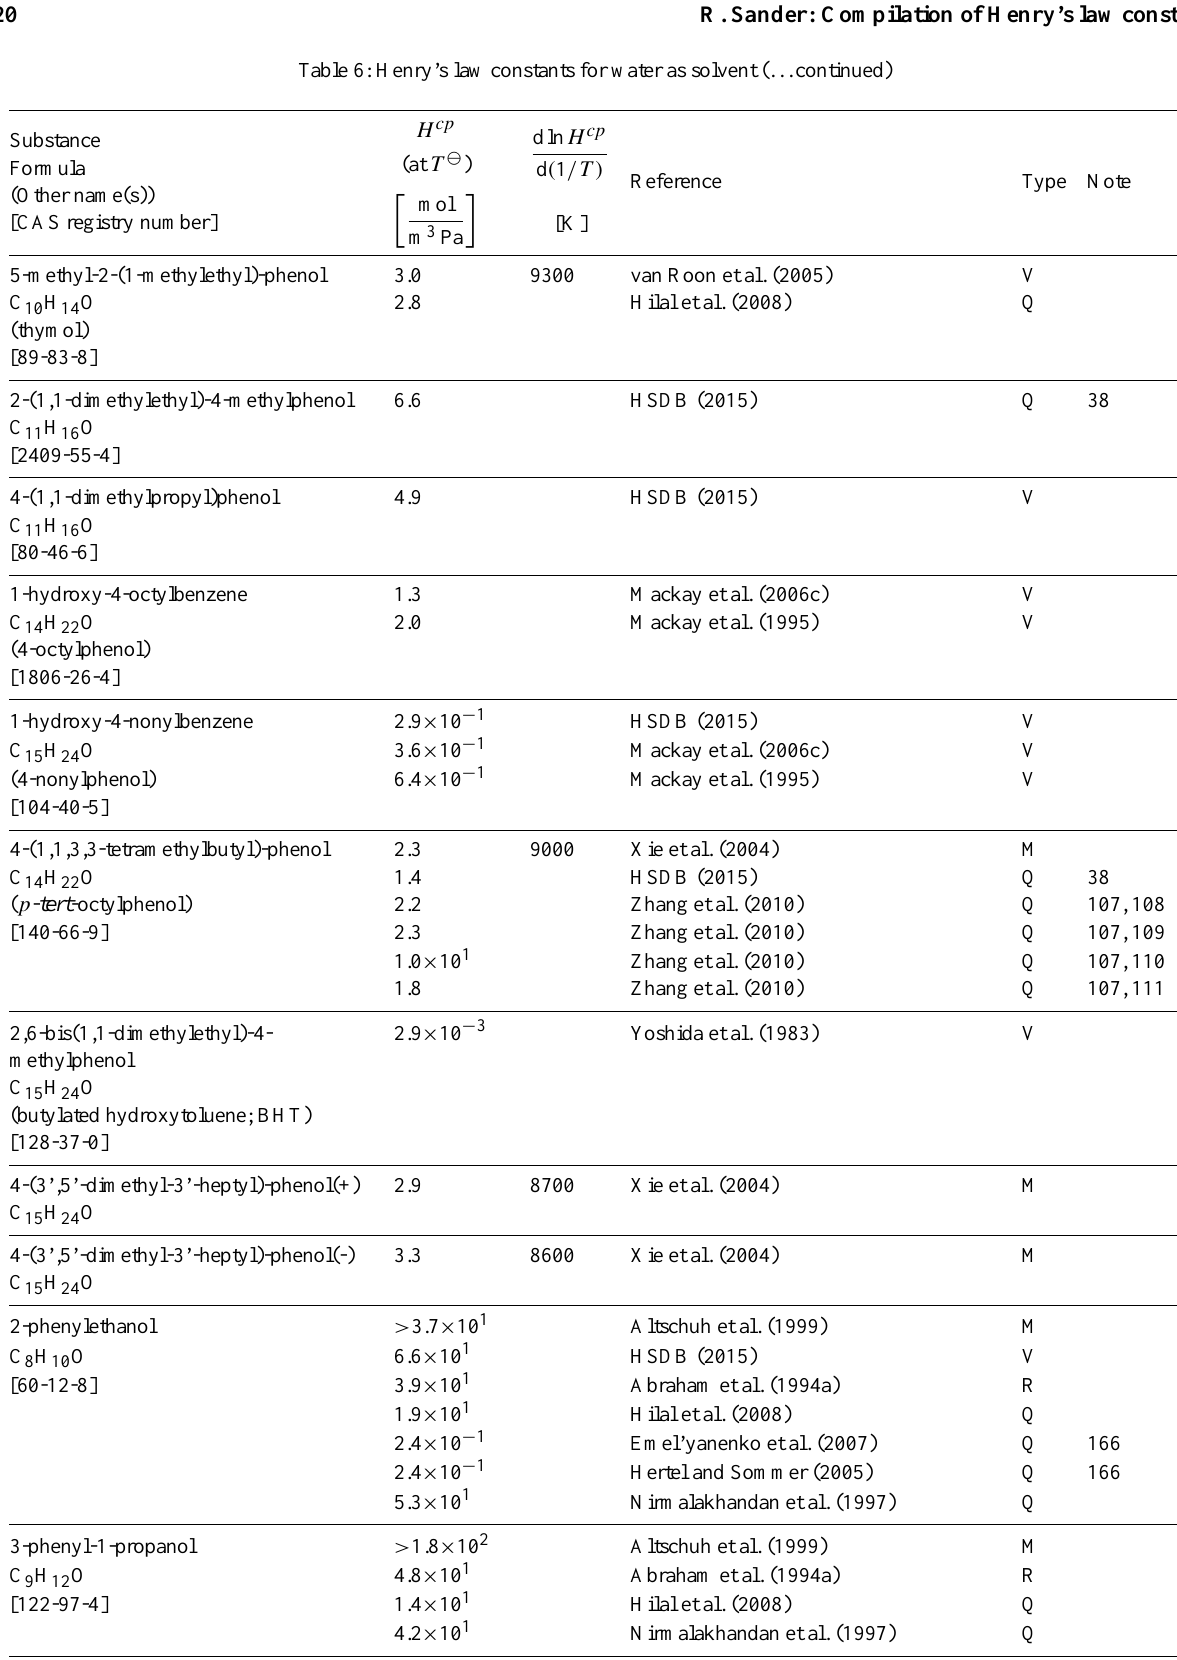
Table 6: Henry’s law constants for water as solvent